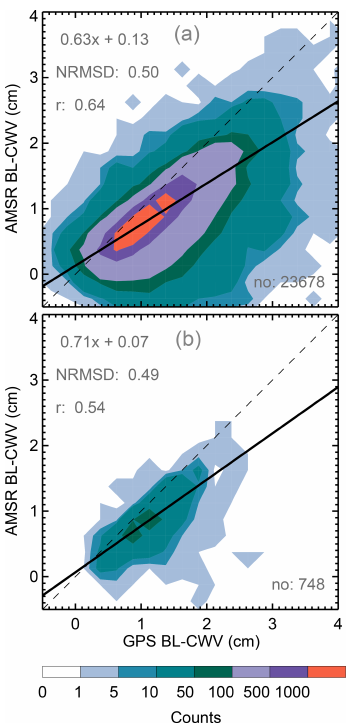
Figure 5. AMSR–GPSRO BL-CWV measurements scattered against the AMSR–MODIS BL-CWV measurements using ± 10km, ± 6h, and a sharpness parameter greater than 2.5 (a) and ± 10km, ± 6h, and a sharpness parameter greater than 3 (b) as coincidence criteria. The dashed black line is the one-to-one line. The solid black line displays a linear fit. The normalized root mean square deviation, the linear fit equation, the correlation coefficient R , and the total number of matches are shown.